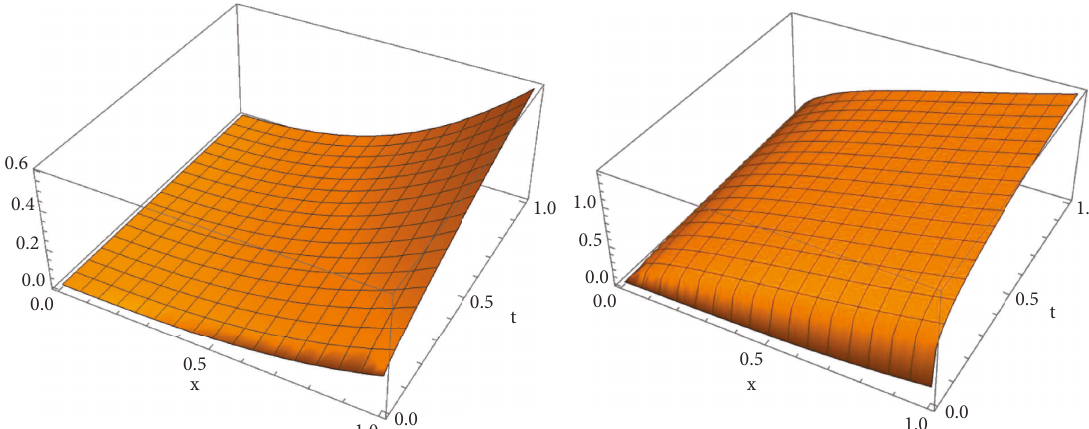
Figure 5: Comparison of the solution at various values of alpha and beta. (a) Early strength. (b) Early strength loss rate.